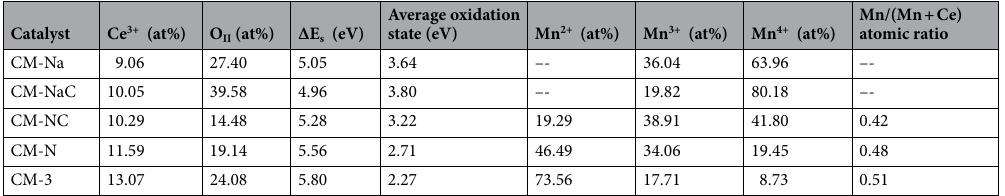
Table 3. Surface elemental analysis derived from